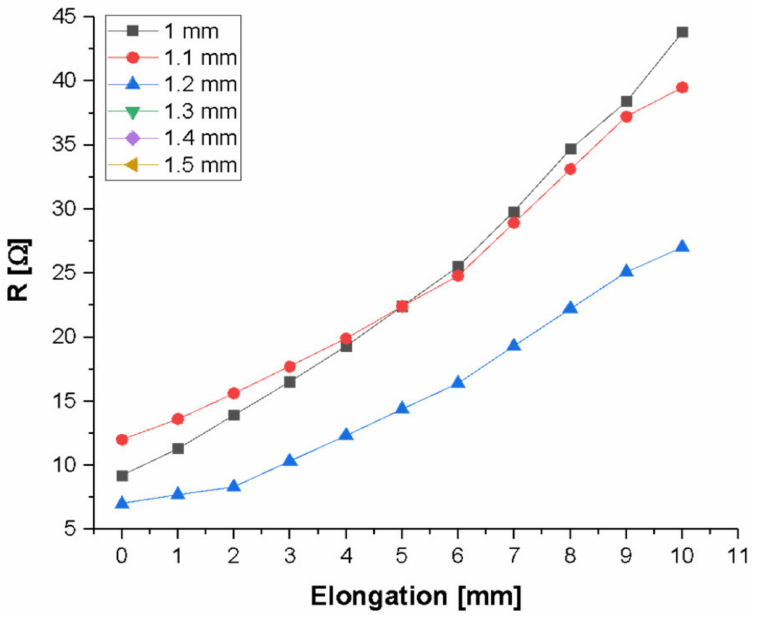
Figure A9. Resistance variation of each pattern of the Inkron IPC-603X screen-printed ink on the Novotex SK81SS + 06 substrate according to the elongation.